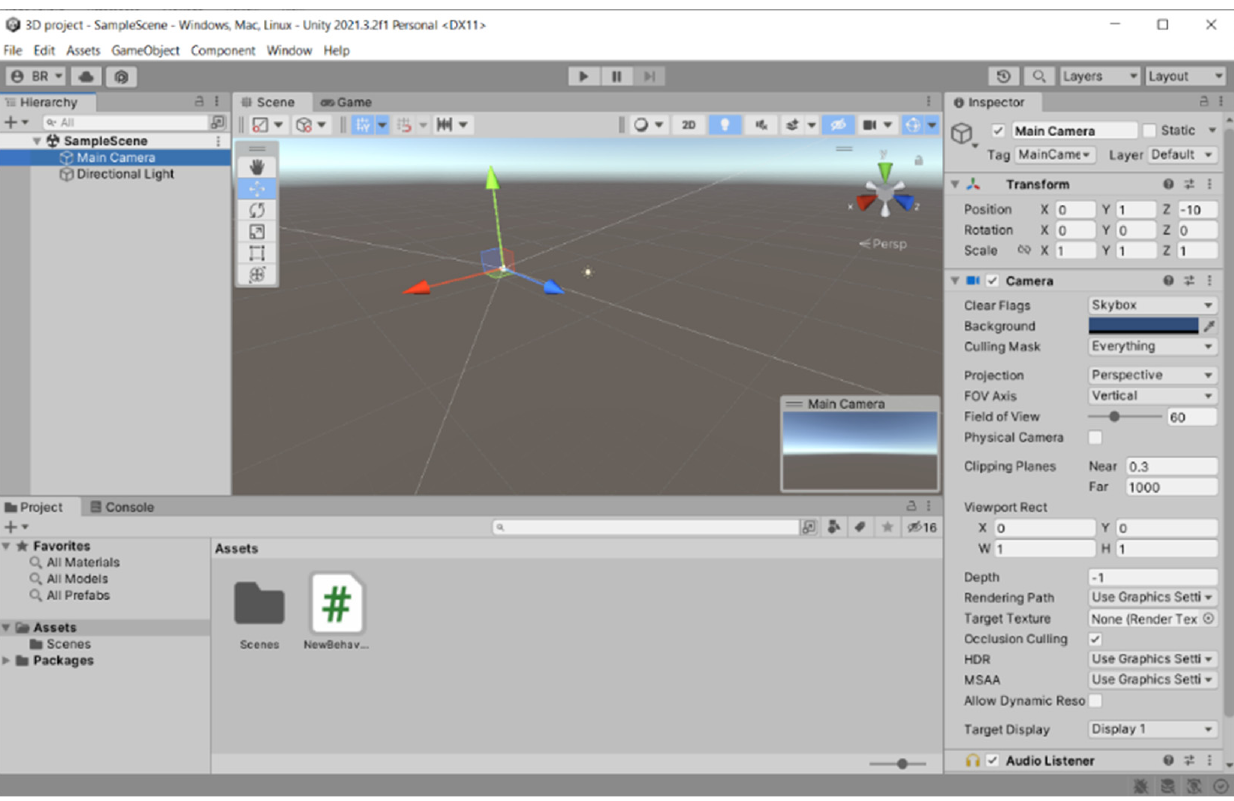
Figure 4. VR module (Unity3D capture).